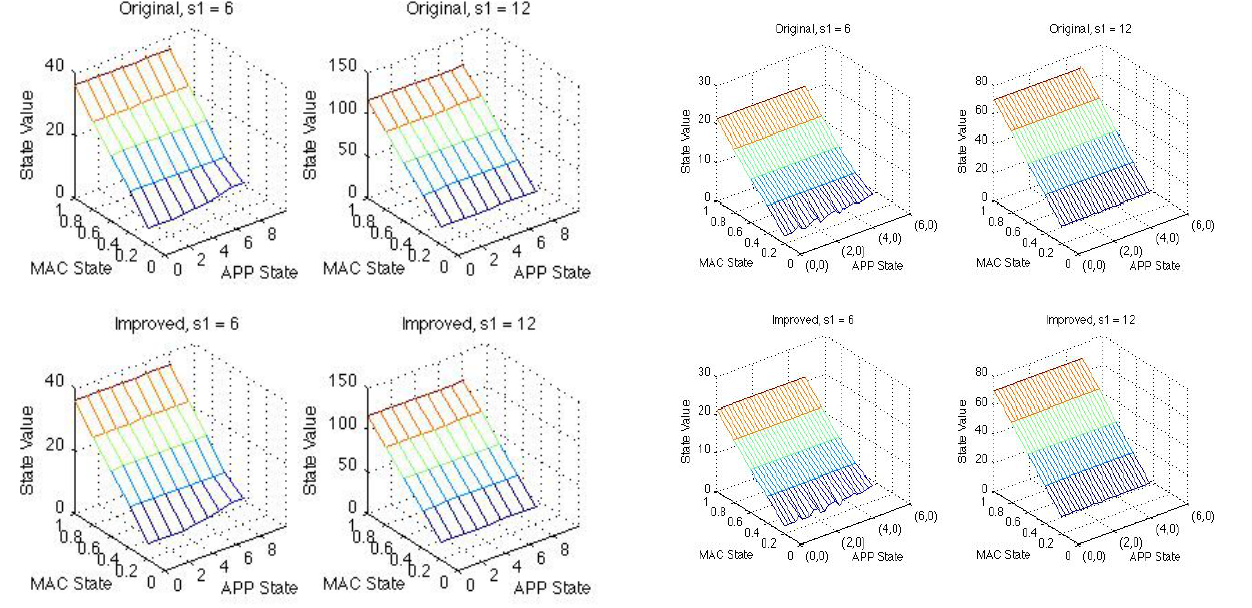
Figure 6a. Simulated state value of throughput efficient application for Bluetooth network.